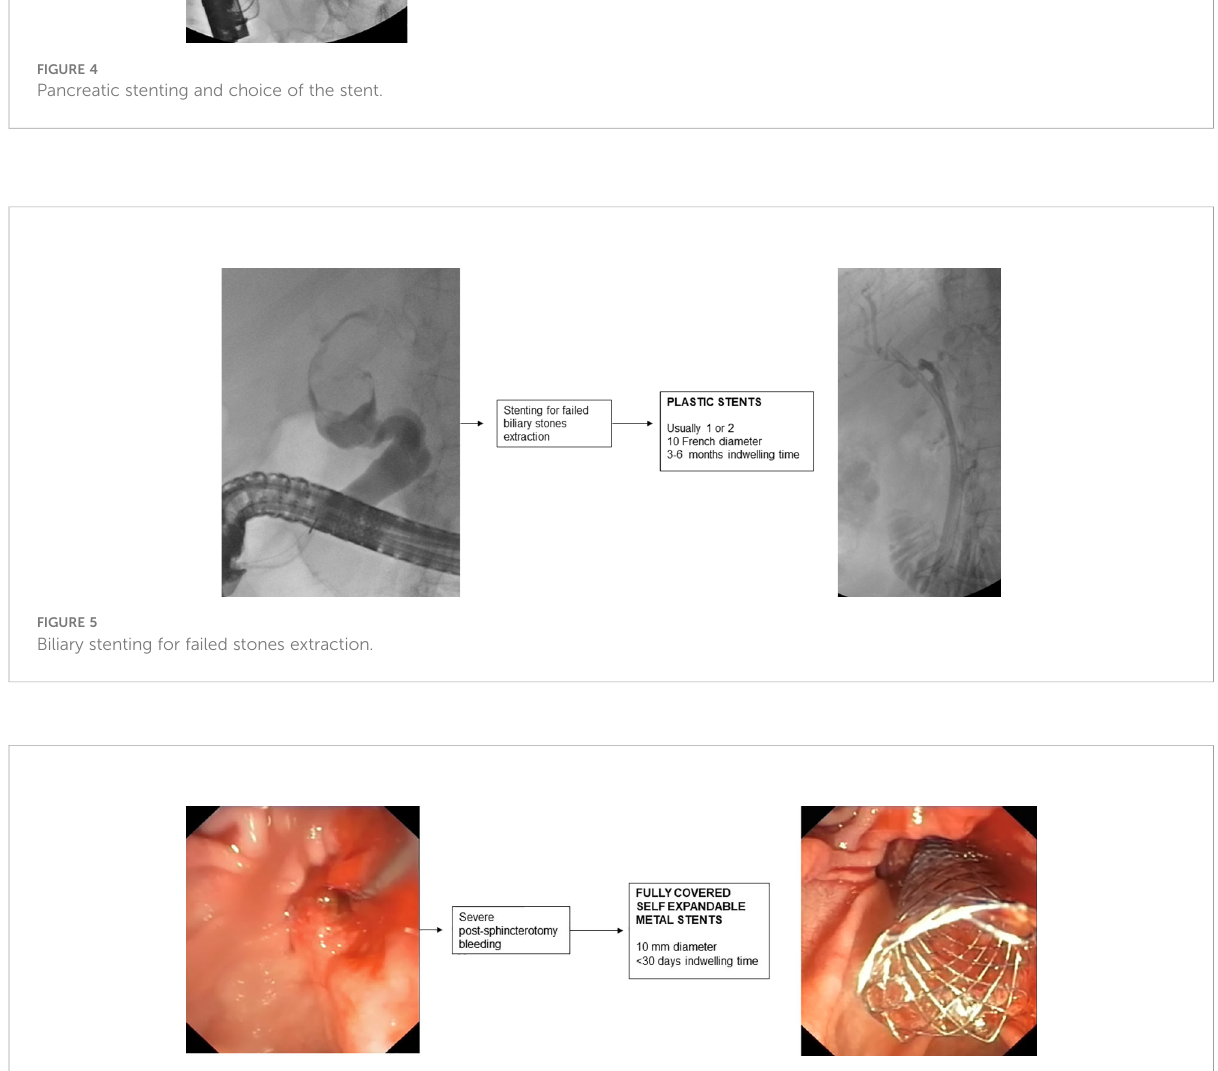
FIGURE 6 Fully covered metal stent for post-sphincterotomy